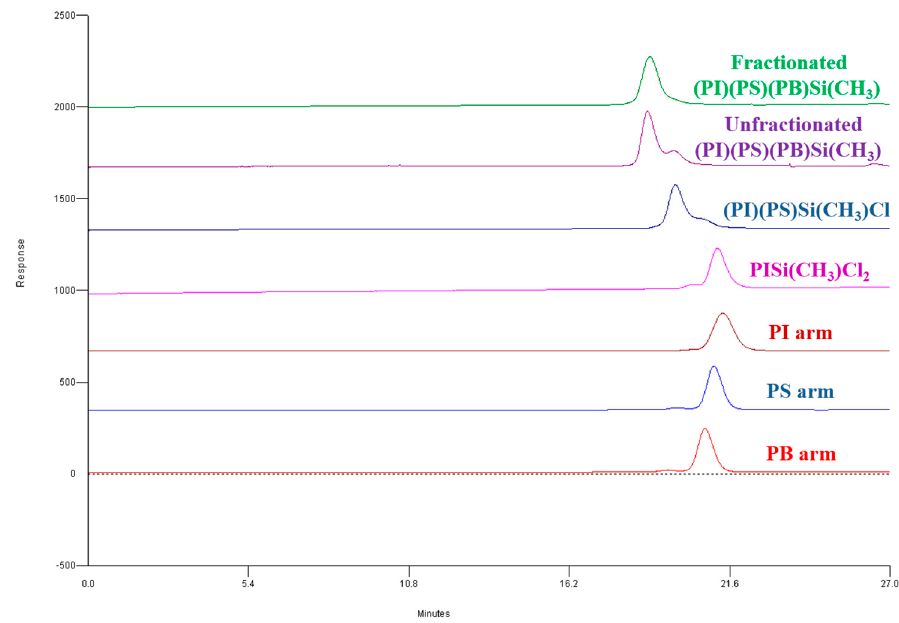
Figure 1. SEC chromatographs of the precursors (PS), (PI ‐ 3,4, 55%), (PB), the intermediate products and the final fractionated 3 ‐ miktoarm star terpolymer (PS)(PI)(PB)SiCH 3 .